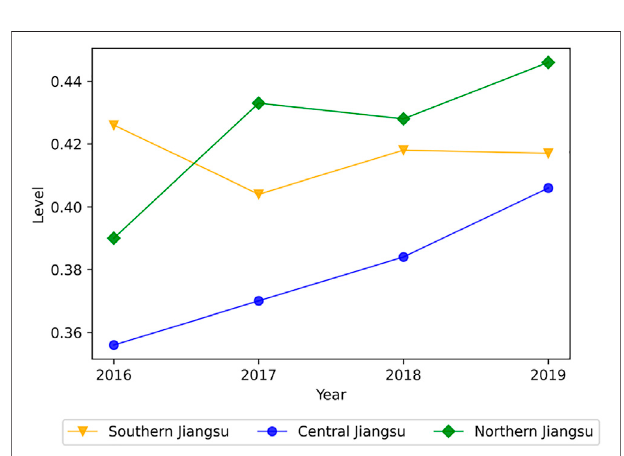
FIGURE 5 | Sadl in different areas in jiangsu